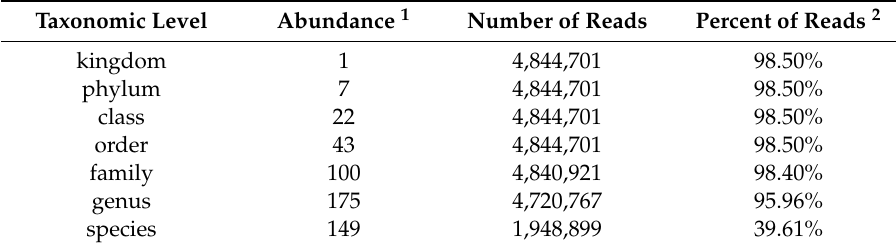
Table 3. Phylogenetic summary of results